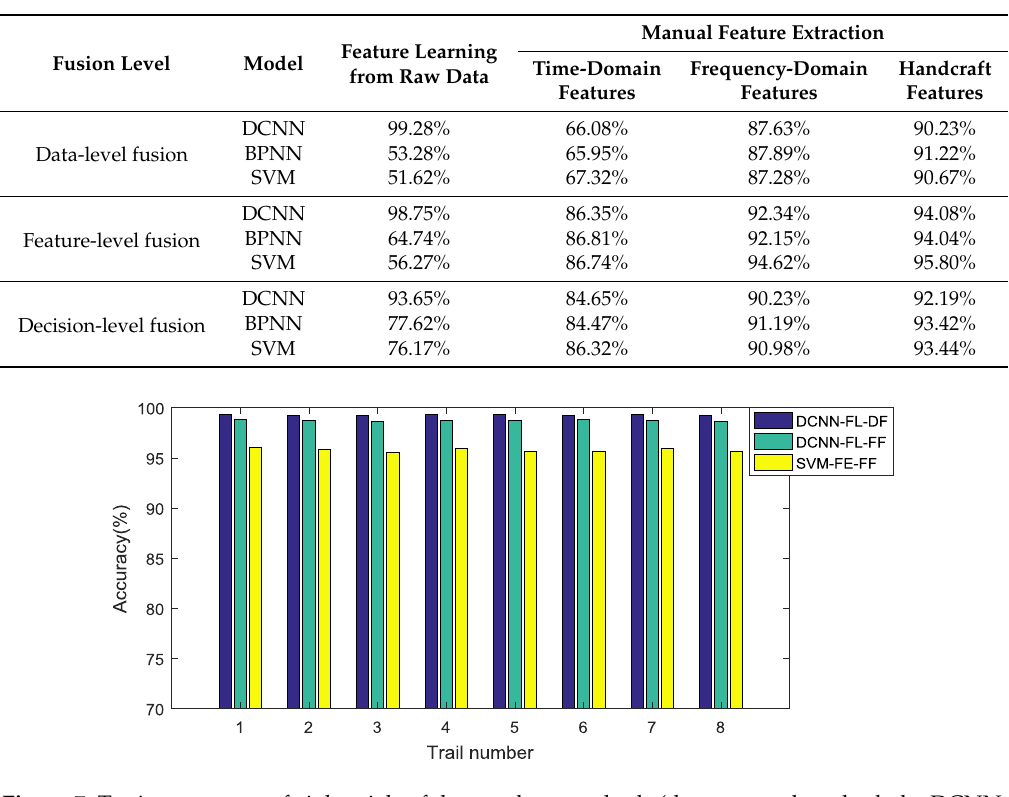
Table 4. Average testing accuracy of comparative methods with multi-sensory data.